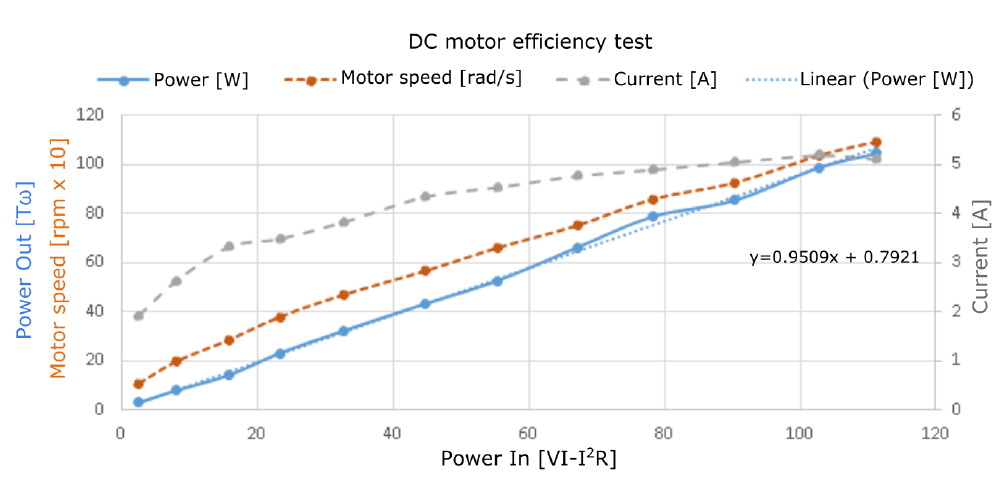
Figure 10. The relationship between the power fed in and the power put out, as measured from the DC motor, to determine the other losses after the copper losses ( I 2 Ra ) have been accounted